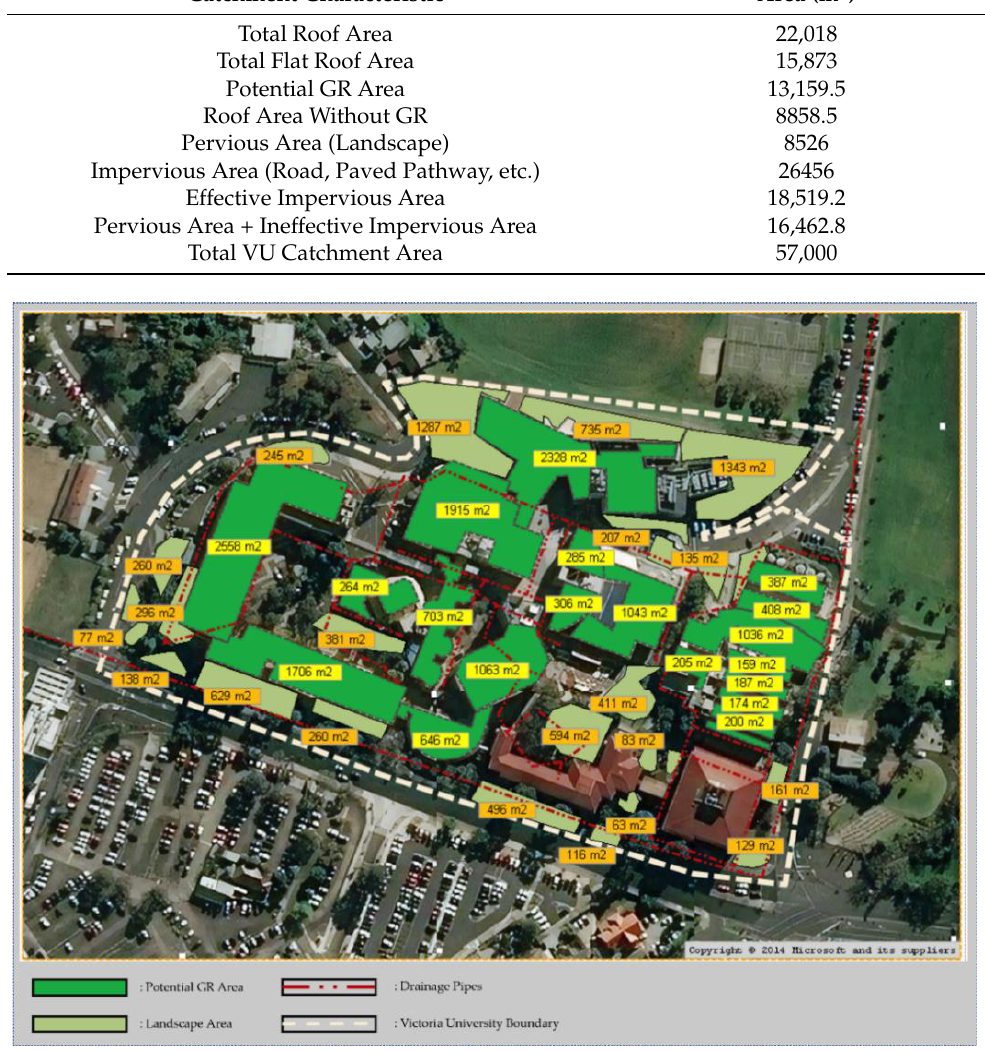
Figure 2. Details of flat roof areas, landscape areas, and stormwater drainage system at VU’s Footscray Park Campus.